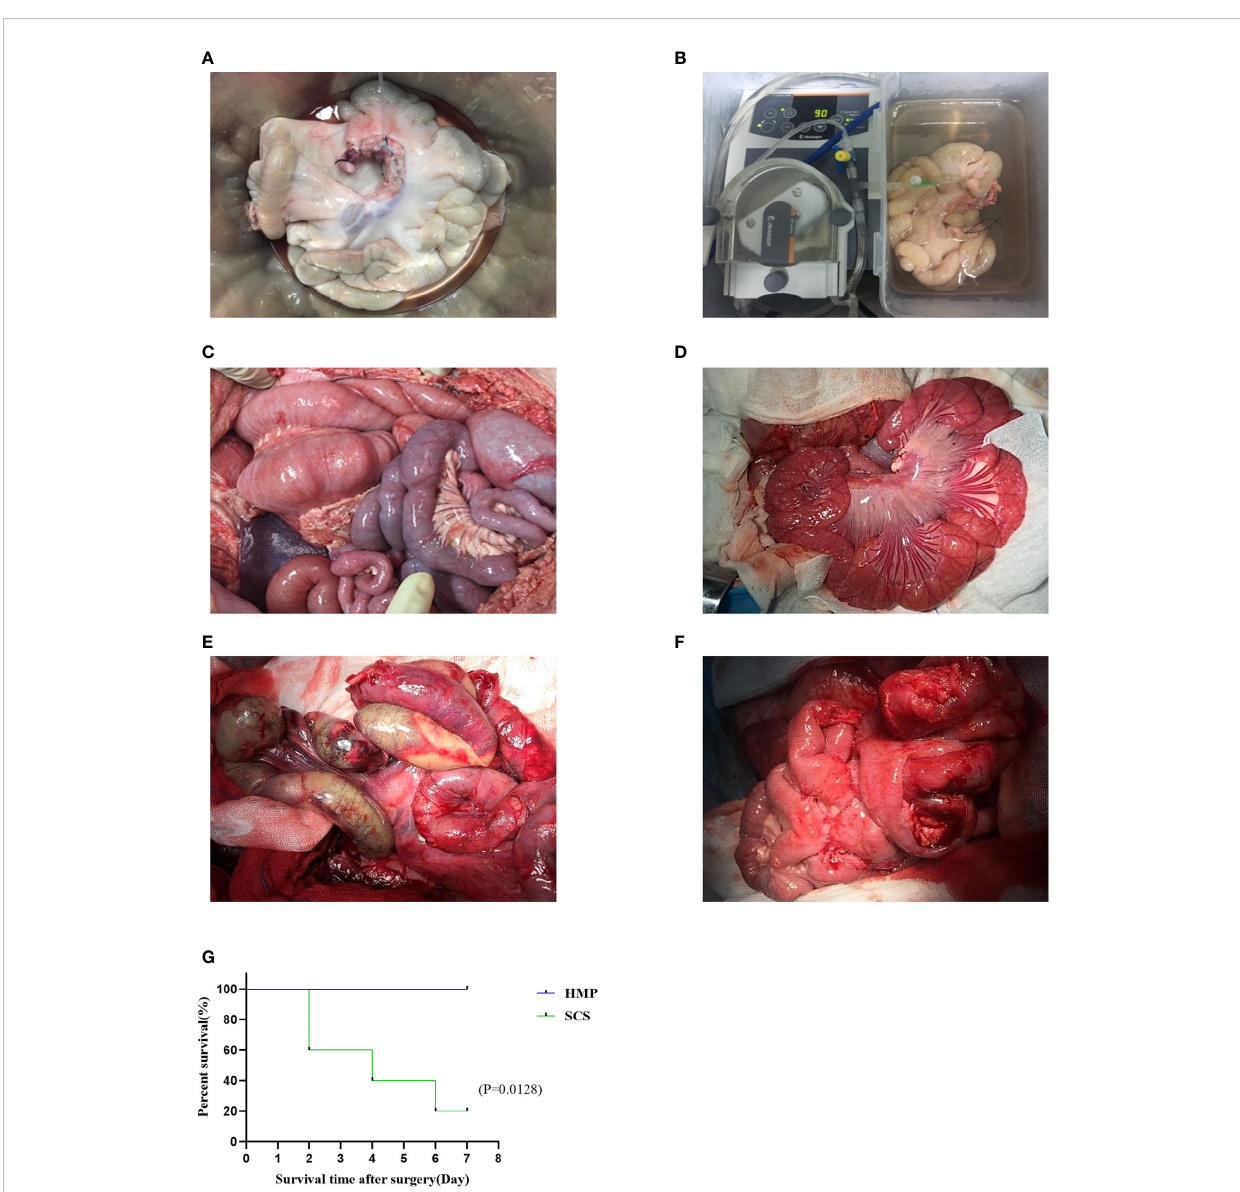
FIGURE 2 Comparison of transplanted intestine between two groups. The intestines of HMP group (A, C, E) and SCS group (B, D, F) were observed respectively at 9 h (A, B) , R0h (C, D) , and POD7 (E, F) . (G) Survival analysis of two groups of intestine auto transplantation